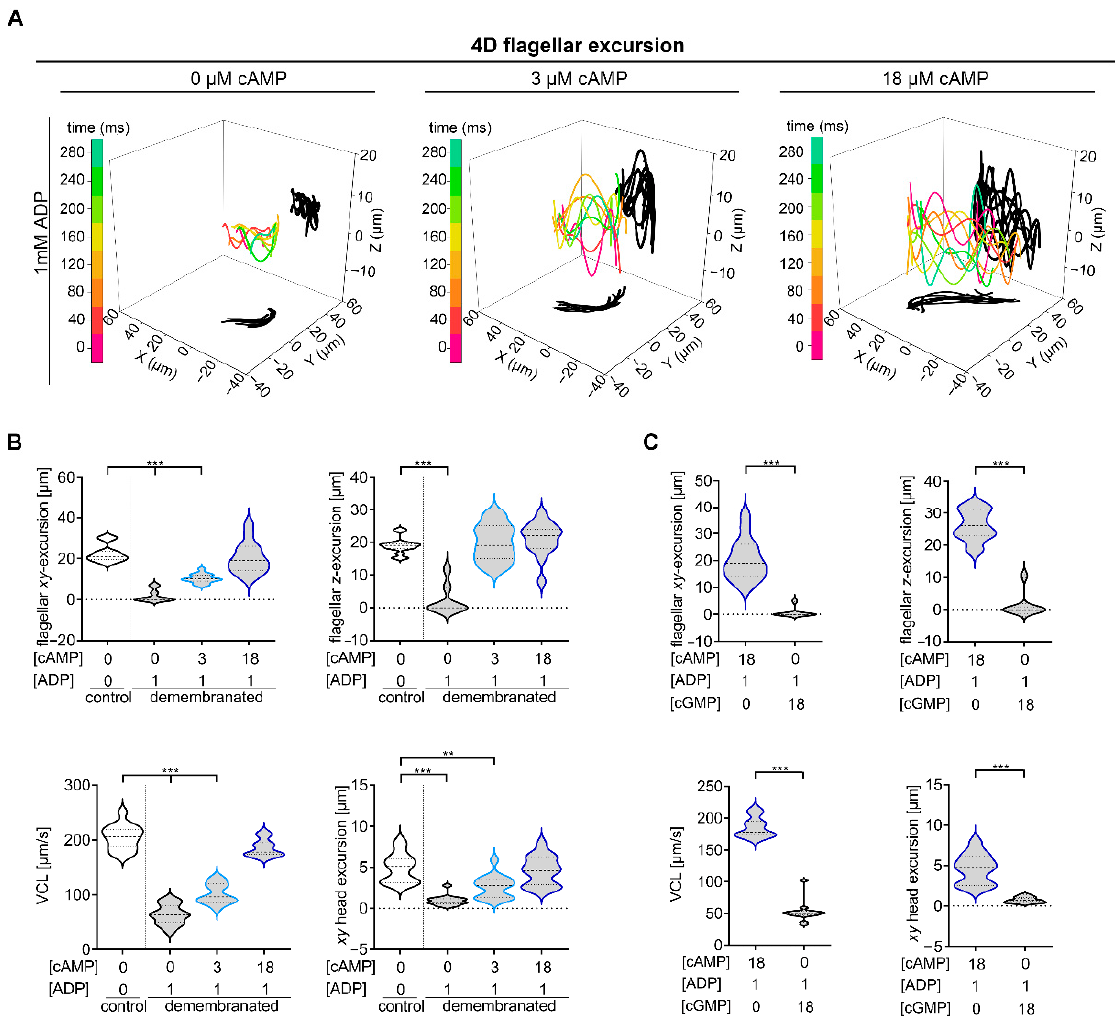
Figure 2. 4D motility of demembranated wt sperm can be recovered by adding 18 µ M cAMP and 1 mM ADP. ( A ) 4D waveform analysis of demembranated sperm analyzed with 1 mM ADP and 0 cAMP (first panel), 1 mM ADP and 3 µ M cAMP (second panel) and 1 mM ADP and 18 µ M cAMP (third panel). Color-coded lines are traces of a flagellum in 3D at different time points (0, 40, . . . , 280 ms) and the projections onto the XY -and XZ -plane are shadowed in black. ( B ) Comparative statis- tical analysis of flagellar XY -(upper panel, left) and Z -excursions (upper panel, right), 3D curvilinear velocity (lower panel, left) and lateral head displacement (lower panel, right) of demembranated sperm measured with 1 mM ADP and 0 µ M cAMP or in the presence of 3 µ M or 18 µ M cAMP. ( C ) Comparative statistical analysis of flagellar XY -(upper panel, left) and Z -excursions (upper panel, right), 3D curvilinear velocity (lower panel, left) and lateral head displacement (lower panel, right) of demembranated sperm measured in the presence of cAMP or cGMP. cGMP does not recover sperm motility in demembranated sperm. N = 4, n = 15, ** p < 0.01, *** p < 0.001, median: thick dashed lines; interquartile range: thin dashed